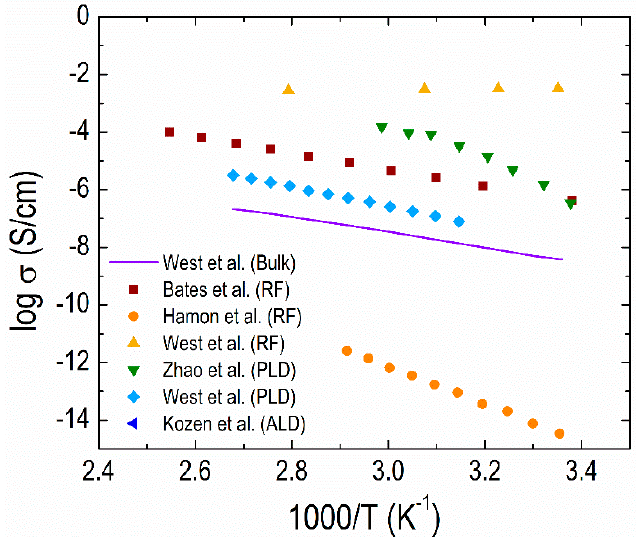
Figure 13. Conductivity summary of bulk [412] and thin-film LiPON deposited via PLD [411,412], RF sputtering [179,409,410] and ALD [413] .